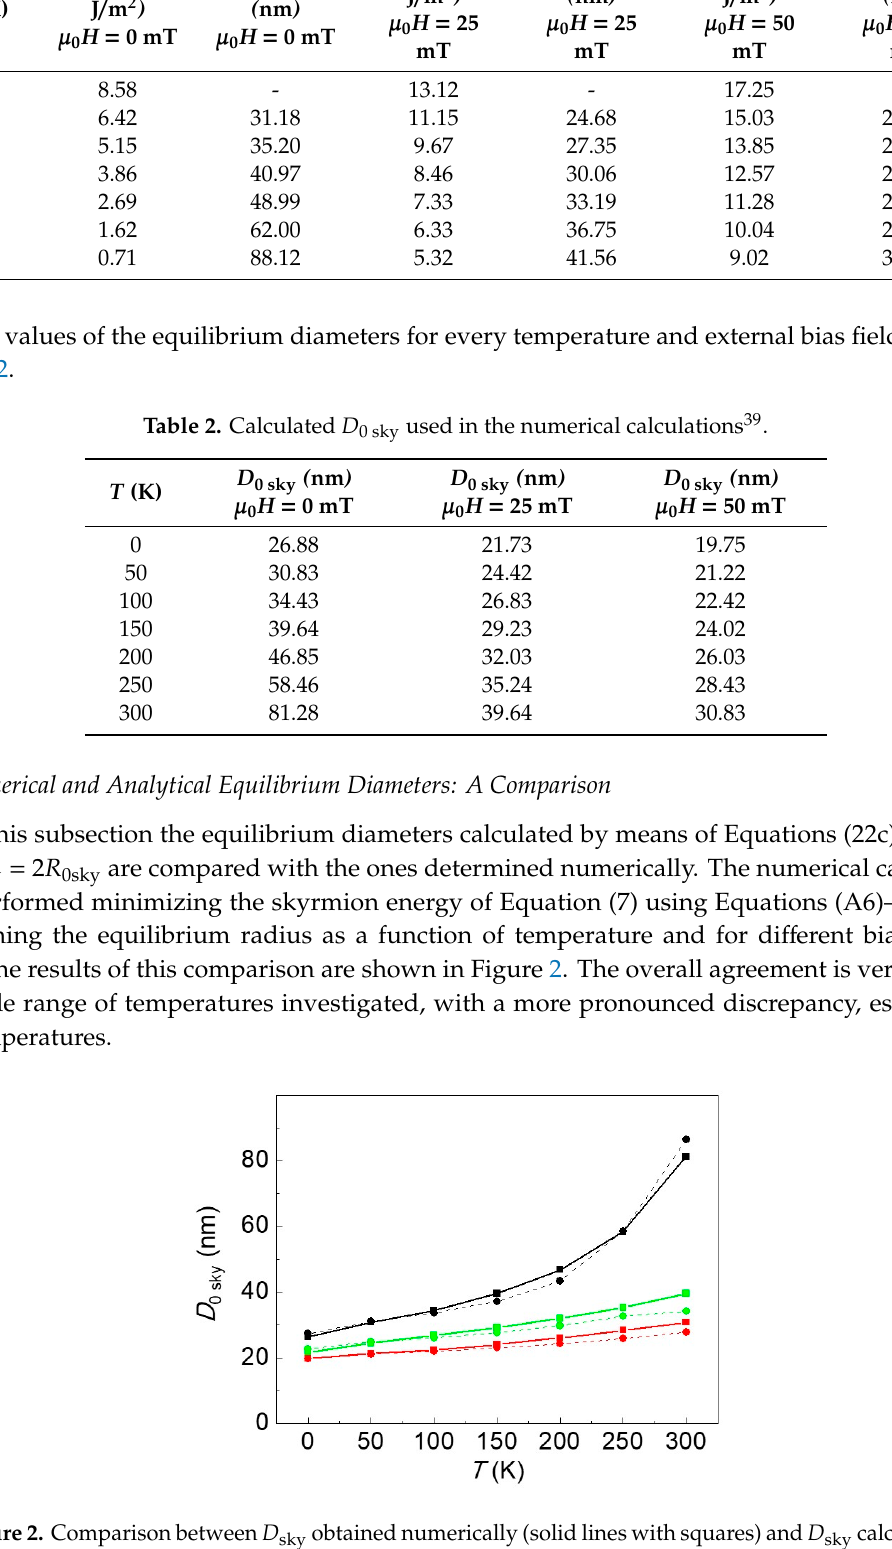
Table 1. Calculated a and < D sky > used in the numerical calculations 39 .